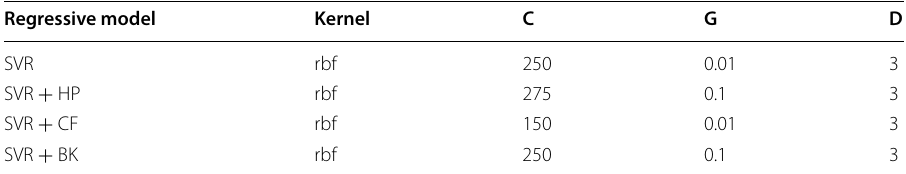
Table 2 Kernel parameters